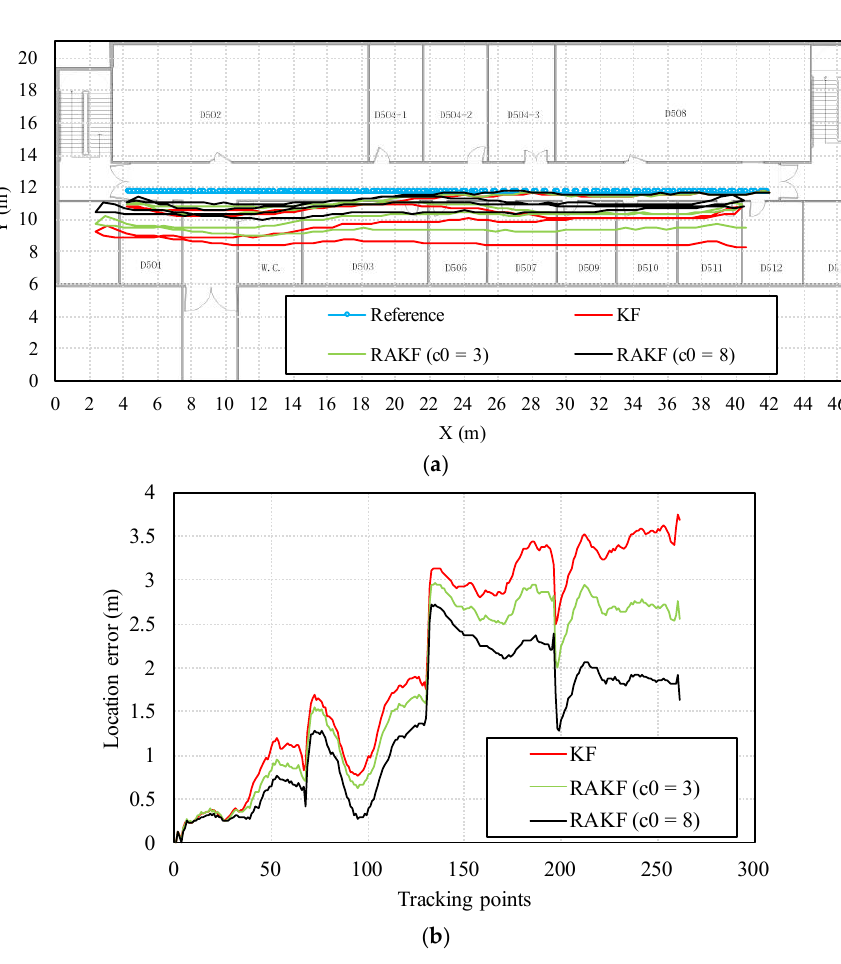
Figure 14. Location tracking performances in terms of ( a ) trajectory, ( b ) location error distribution of different algorithms regarding the participant 3.